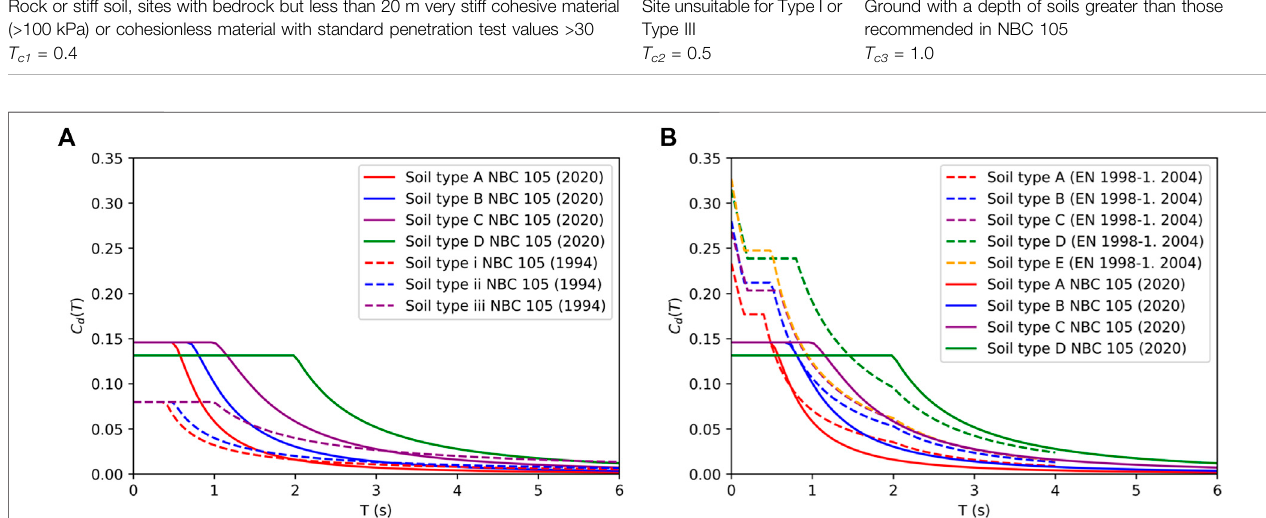
FIGURE 1 | (A) A comparison of the design spectra, for an RC moment-resisting frame, in Kathmandu for the old Nepalese design code (NBC 105, 1994) and the updated Nepalese design code (NBC 105, 2020); (B) Comparison for the design spectra, for an RC moment-resisting frame in Kathmandu, for the updated Nepalese design code (NBC 105, 2020) and Eurocode 8 with a behaviour factor equal to 4.95 (CEN, 2004).